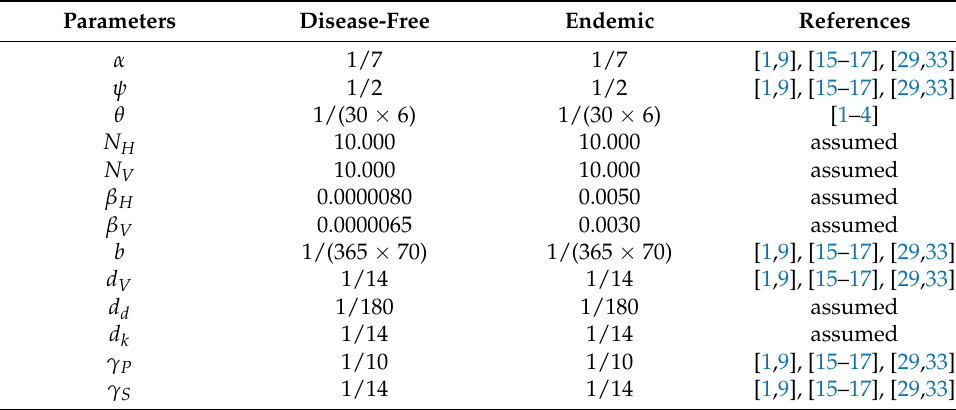
Table 3. The parameters used in the numerical